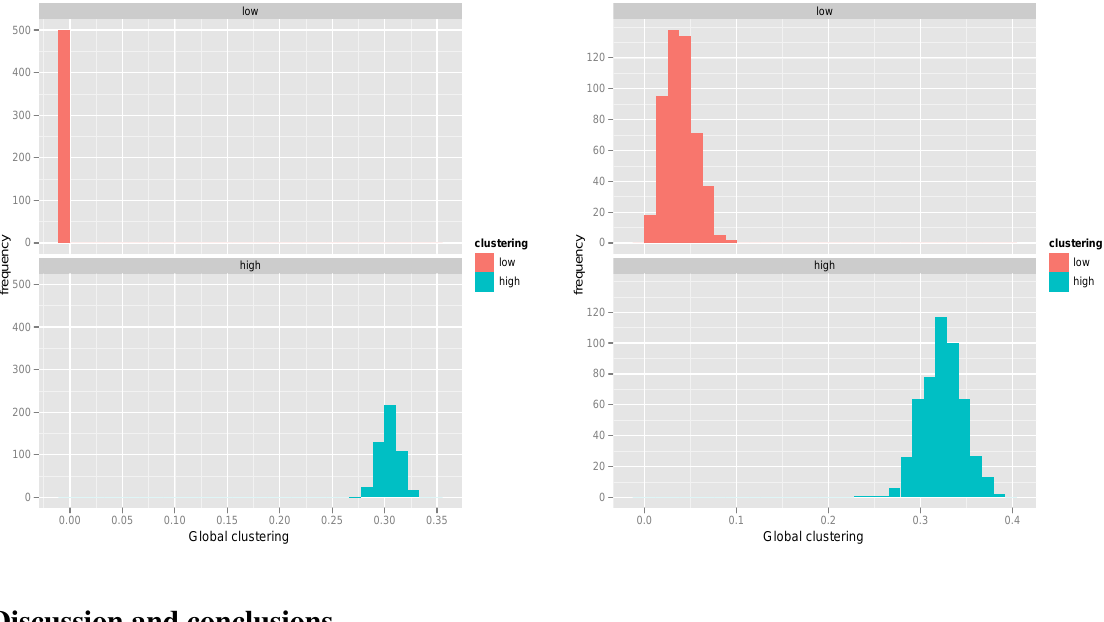
Clustering coefficient for (left) Bernoulli networks and (right) power-law